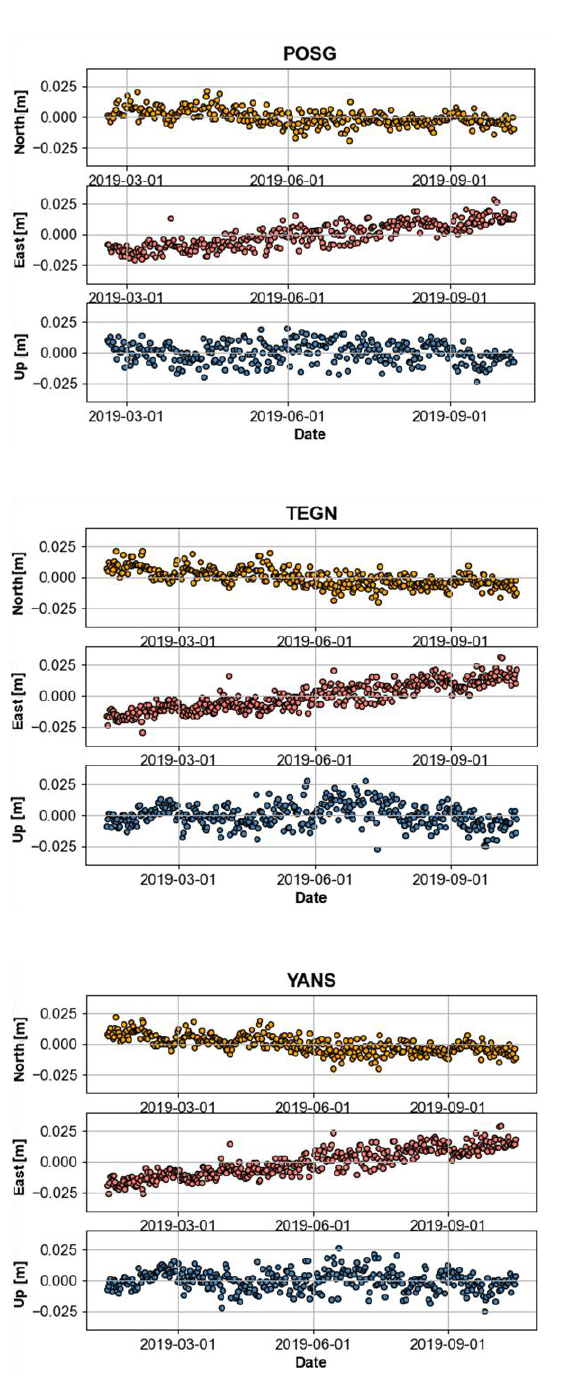
Figure A2. Time series GNSS Station in 2019.